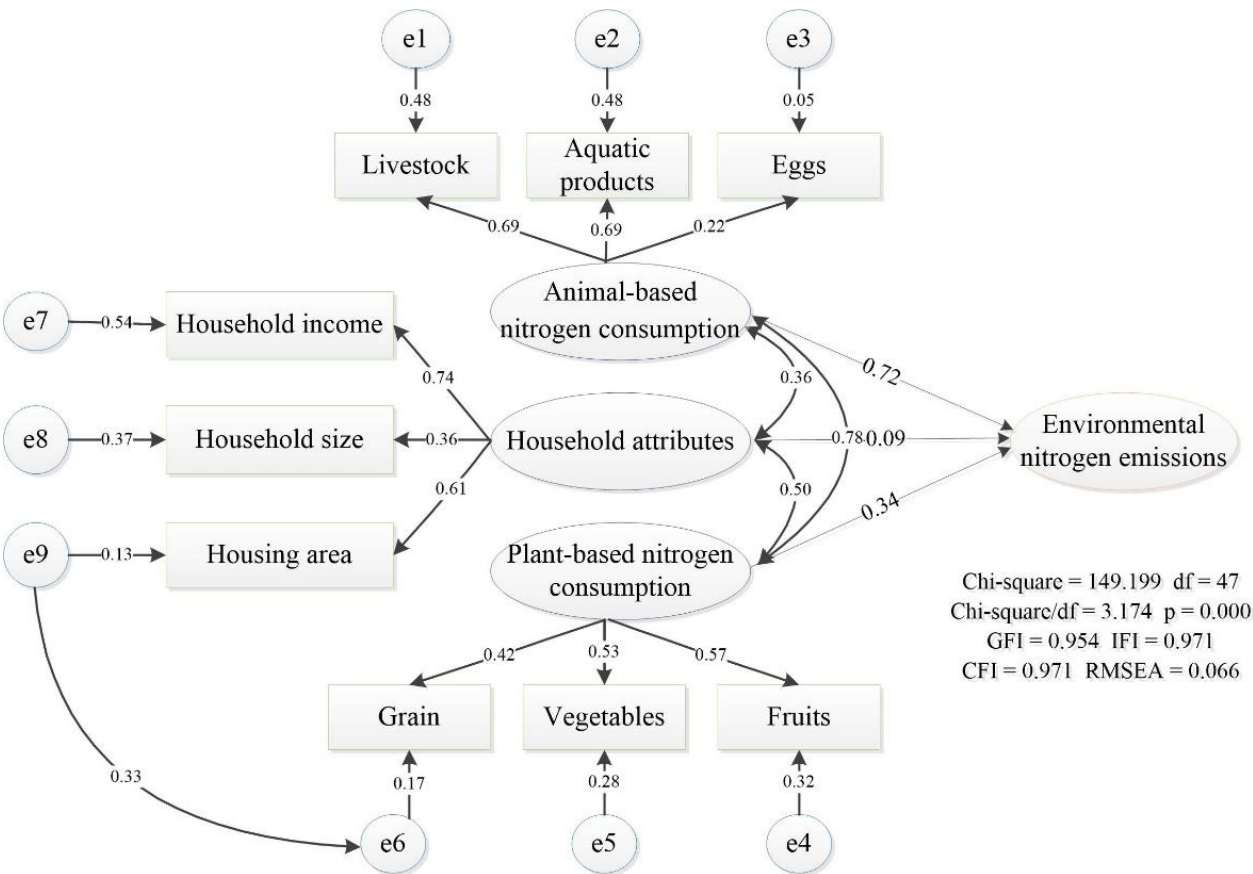
Figure 6. Influencing mechanism of key factors on the food-sourced environmental nitrogen emissions of the six income groups of households.